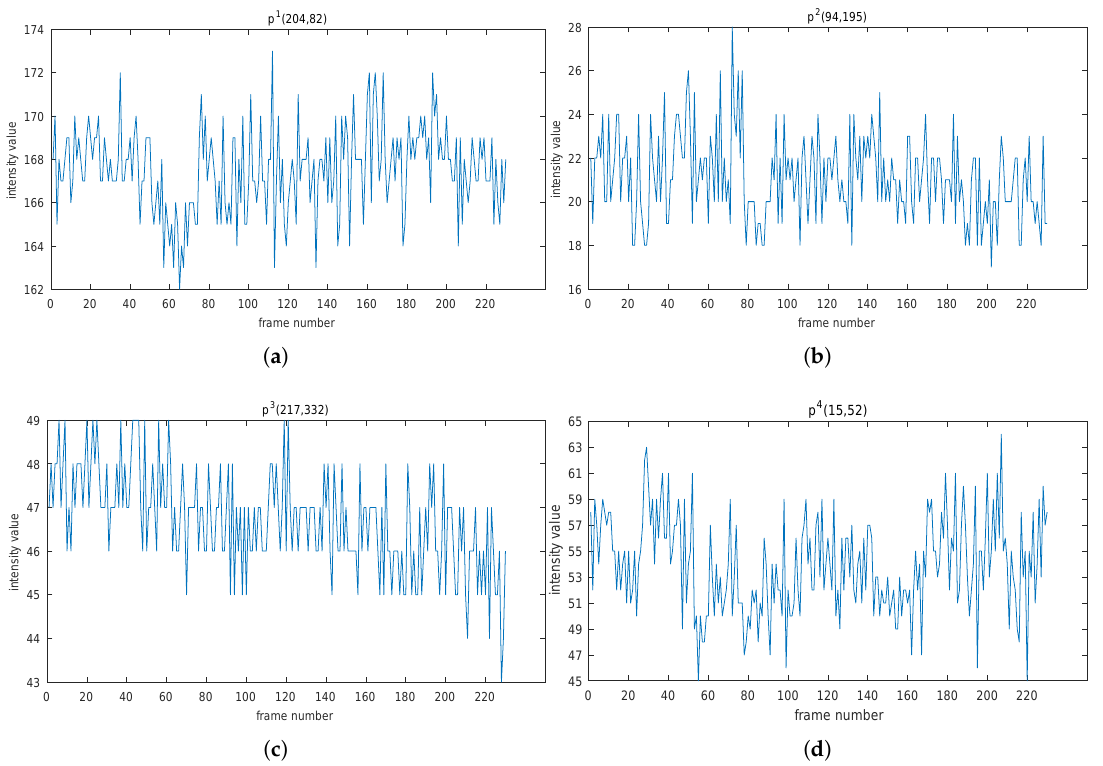
Figure 1. Points p 1 (204, 82) in ( a ), p 2 (94, 195) in ( b ), p 3 (217, 332) in ( c ), and p 4 (15, 52) in ( d ) are selected randomly from the scene bus station in category shadow [6]. Those four subfigures display the variation trend of the intensity values of the four points over a period of time. The X -axis’ name, frame number, indicates the order of each frame in a video in the temporal